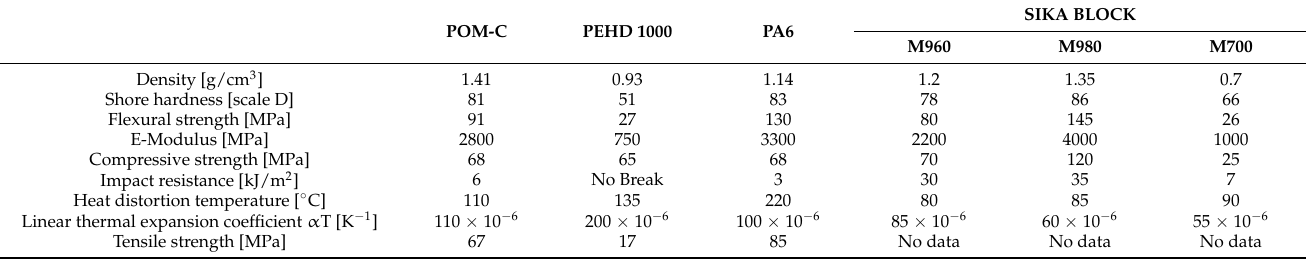
Table 1. The mechanical characteristics of the materials by the Quality Certificates issued for the purchase of semi-finished products.